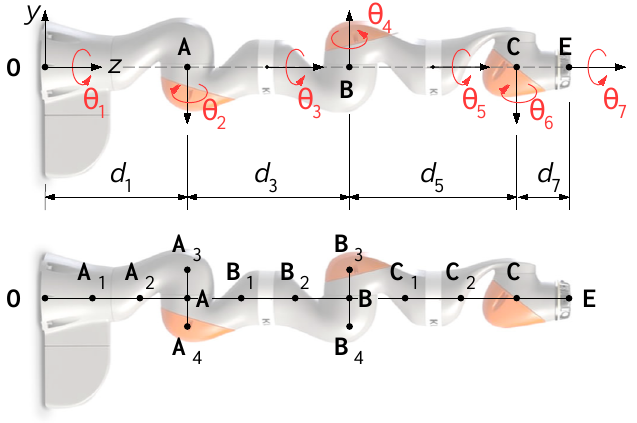
Figure 5. Kinematic chain ( top ) and control points ( bottom ) for the KUKA LBR iiwa robot